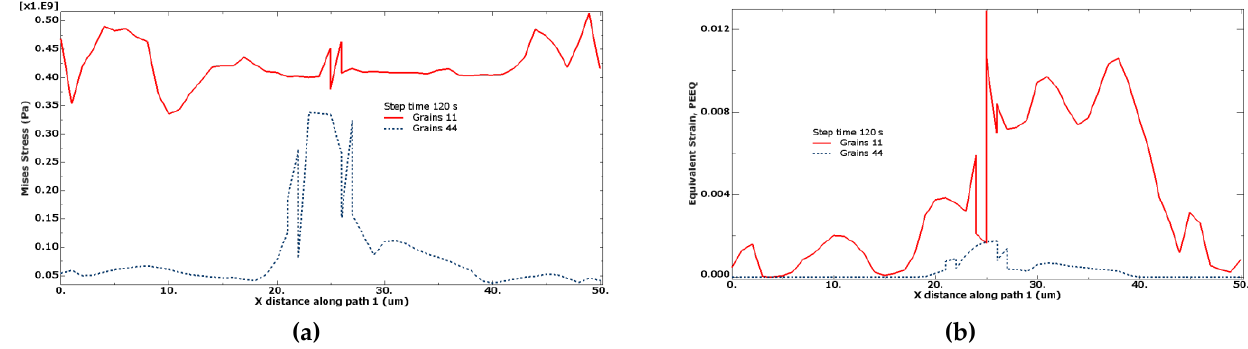
Figure 6. Mises stress and equivalent strain (PEEQ) vs. X distance along path 1 at the step time 120 s for the analyzed RVE specimens; ( a ) Mises stress values in Pa; ( b ) equivalent strain (PEEQ) values.